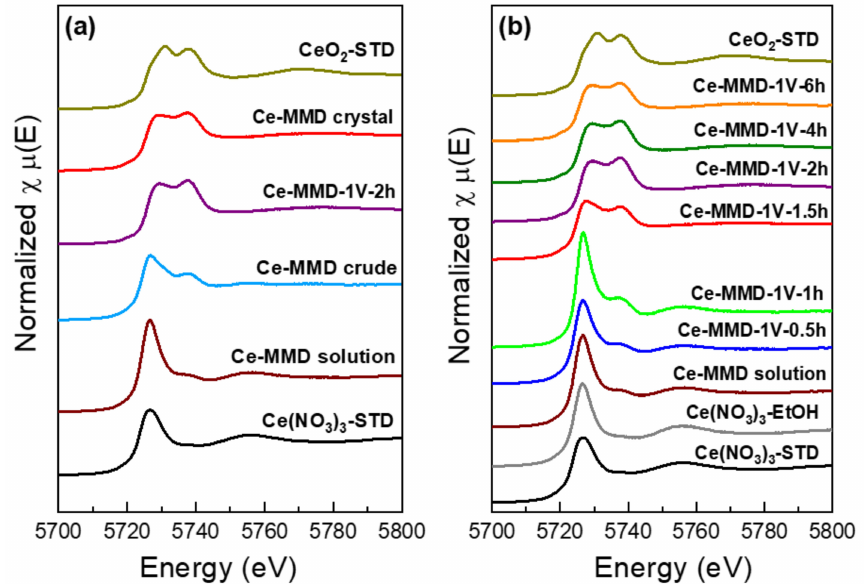
Figure 13. X-ray absorption near edge structure (XANES) spectra probed at Ce L3 edge to monitor the oxidative complexation formation of the desired Ce-MMD. ( a ) A comparison of Ce L3 edge XANES spectra of the obtained products at various stages of the synthetic procedure (namely the direct mixing Ce-MMD solution, the Ce-MMD crude, and the Ce-MMD crystal) with respect to the standard Ce(NO 3 ) 3 and CeO 2 compounds. ( b ) The Ce L3 edge XANES spectra of the obtained products obtained from various stages during the chronoamperometry by applying a fixed voltage of 1 V to the